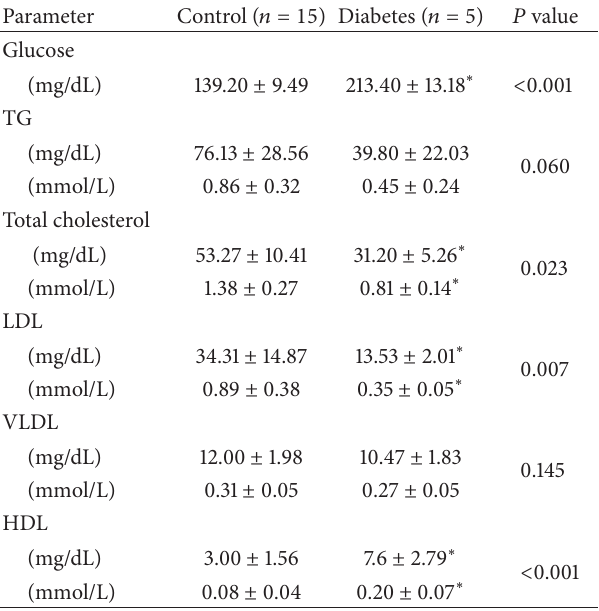
Table 1: Mean blood glucose and lipid profile in type 1 diabetic and control guinea pigs.